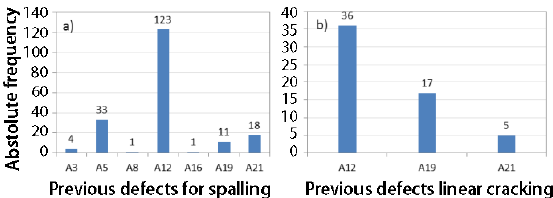
Fig. 13. Absolute frequency of previous defects for a) spalling (A8) and b) linear cracking (A5) in concrete elements